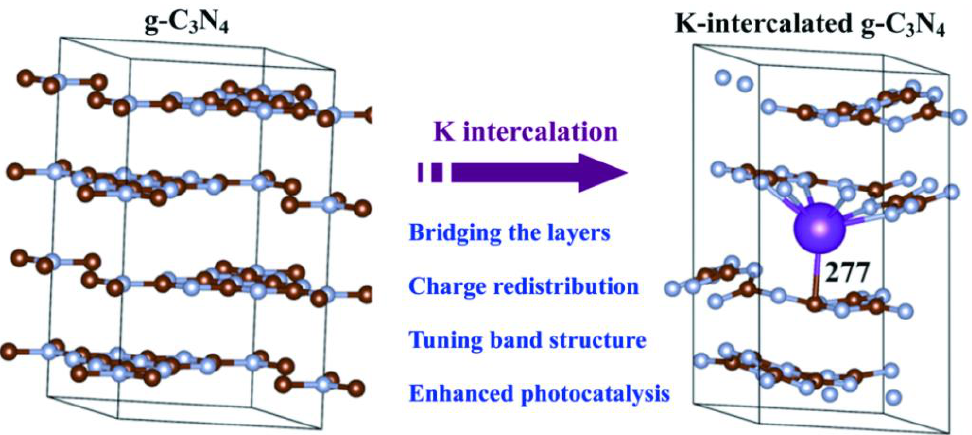
Figure 7. The proposed mechanism of K intercalation to improve photocatalytic performance of g − C 3 N 4 [100]. Copyright 2016, American Chemical Society. g − C 3 N 4 [100]. Copyright 2016, American Chemical